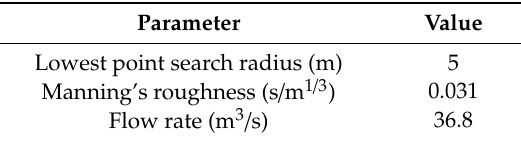
Table 3. Bathy-supp model specific settings.